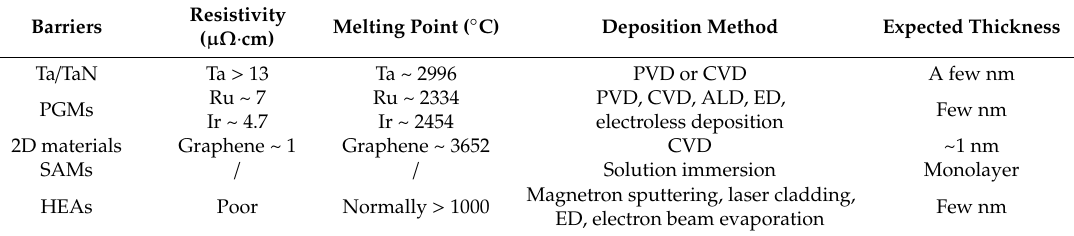
Figure 2. Schematic illustration of the “over-hang” formed by electroless deposition of Cu seed layer, leading to the voids formed by the subsequent electrochemical Cu deposition during a damascene process. ( a ) The formation of Cu overhanging clusters via electroless deposition; ( b ) growth of Cu overhanging clusters during electrochemical Cu deposition; ( c ) failure of Cu super-filling of damascene feature. Reproduced from Hong et al. [79]. Copyright 2005 Elsevier Ltd. All rights reserved. Table 1. Brief comparison of properties, fabrication methods and expected thickness of